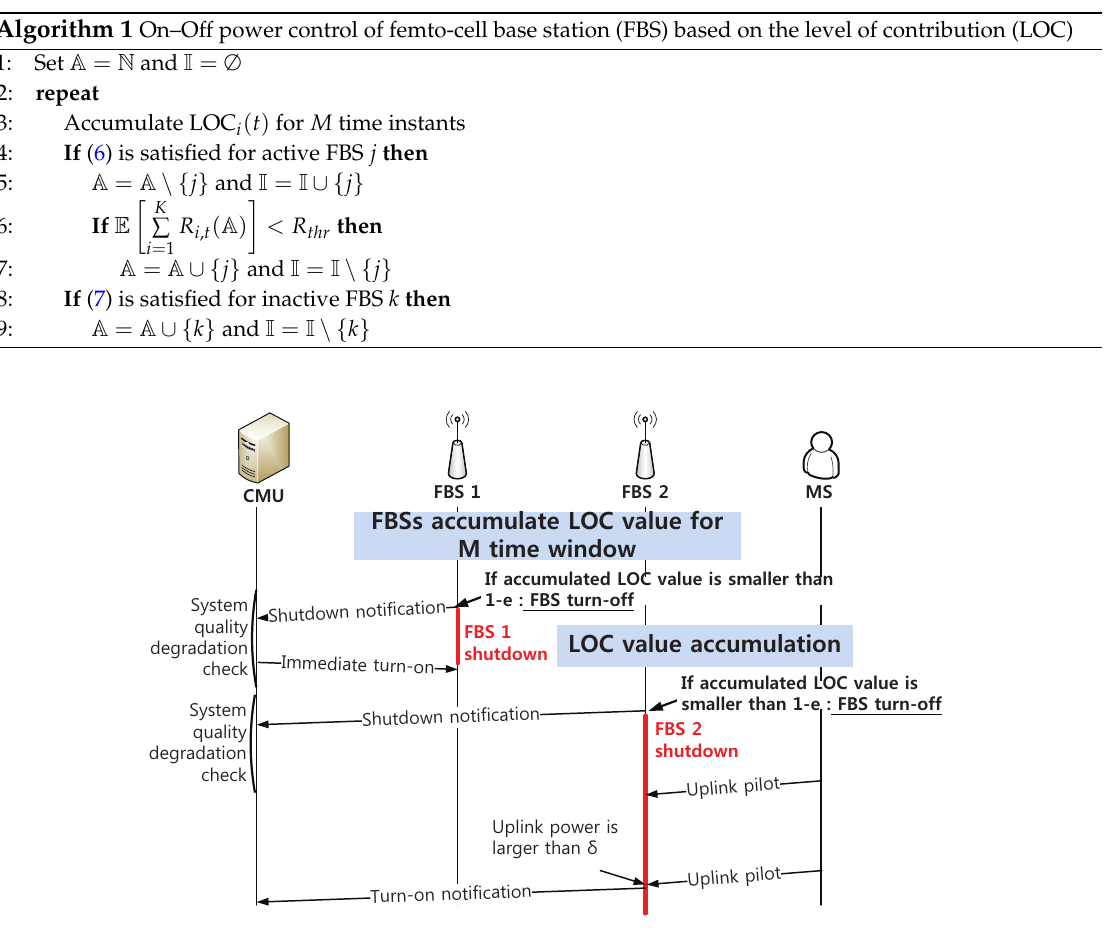
Figure 3. Procedure of proposed on–off power control scheme, LOC: level of